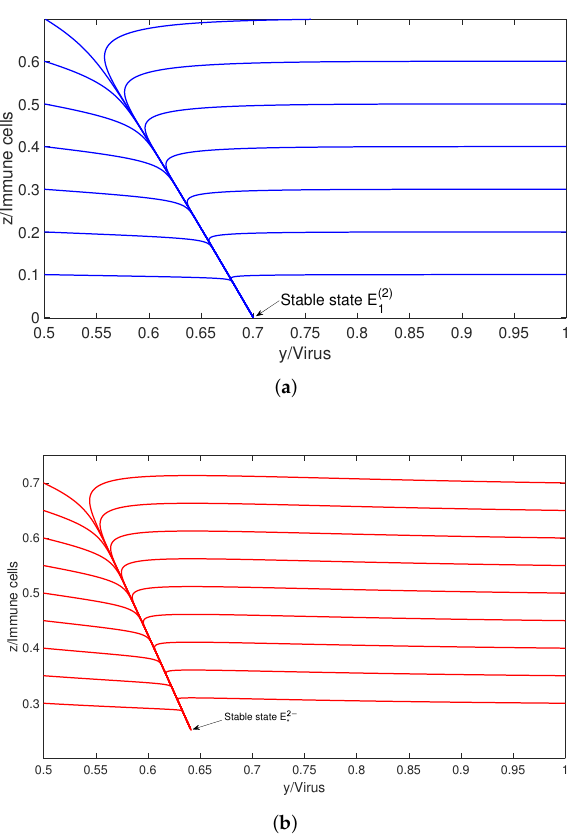
Figure 12. Trajectories of system (2) with different initial values for c = 2.5 day − 1 and c = 2.7 day − 1 . ( 2 ) When c = 2.5 day − 1 , only E is stable (see ( a )). When c = 2.7 day − 1 , only E 2 − ∗ is stable (see ( b )). 1 Other parameter values are listed in Table 4 and K = 1.4 cells/ µ